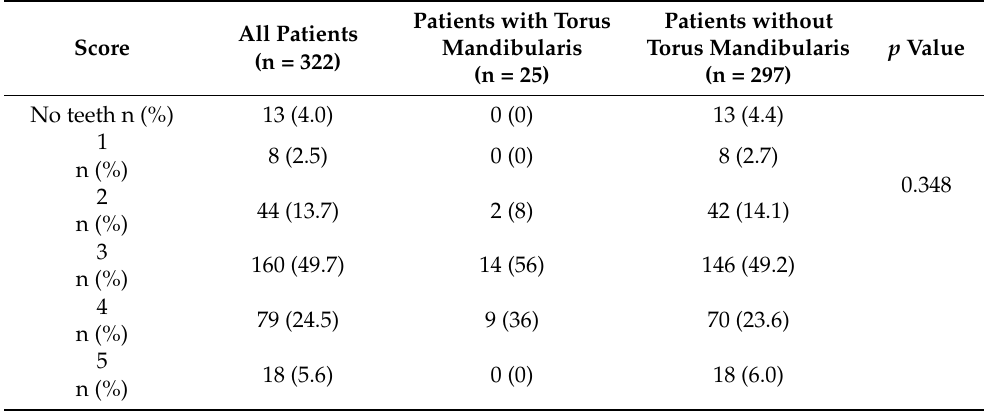
Table 6. Oral hygiene among hemodialysis patients with and without torus mandibularis based on the Turesky-Gilmore-Glickman modification of the Quigley-Hein plaque index (n =